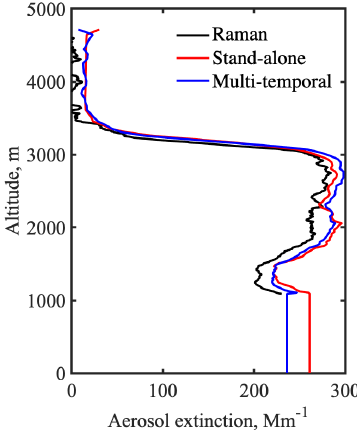
Figure 32. Aerosol vertical distributions retrieved from stand-alone LILAS observations performed on 16 April 2015.